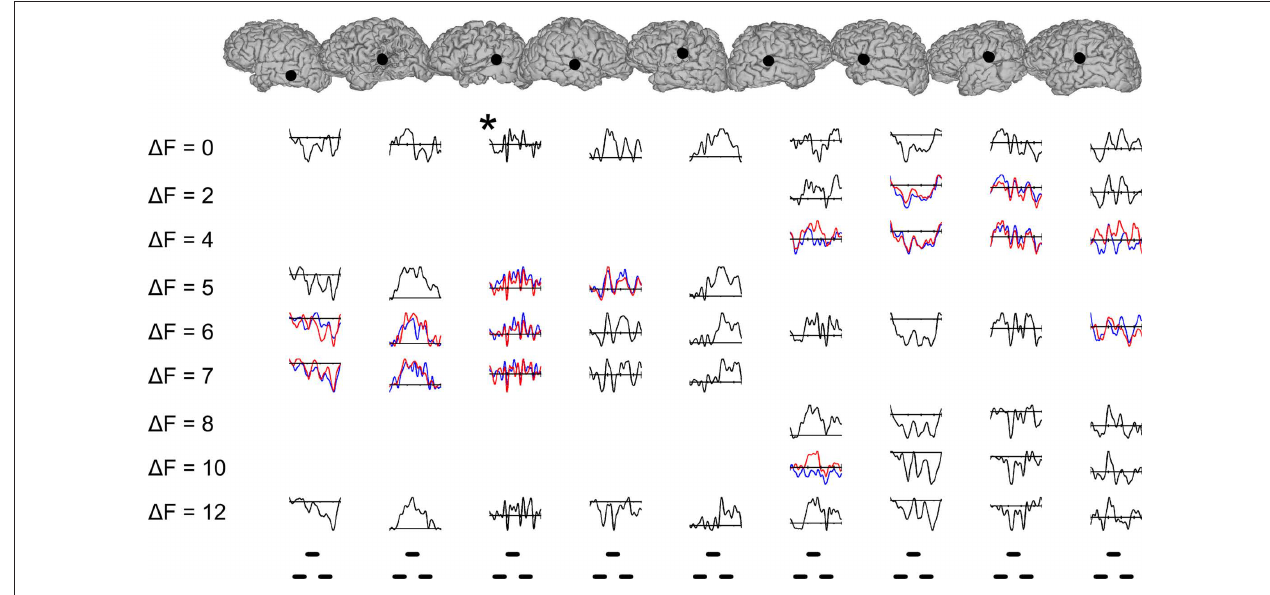
over each subject’s cortical reconstruction, were chosen based on their having the largest RMS power grand-average triplet-locked evoked response in the vicinity of the superior temporal gyrus. The frequency separation ( ∆ F, semitones) for each set of waveforms is indicated in the left-most column. The timing of individual tones in the triplet is shown in the bottom row.